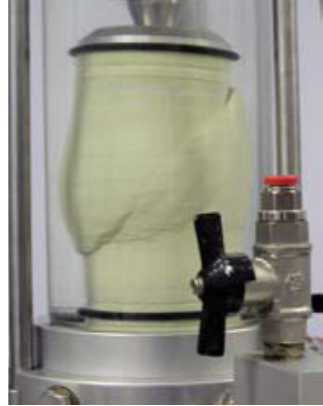
Fig. 8. Triaxial test dense sand sample of H/D = 2